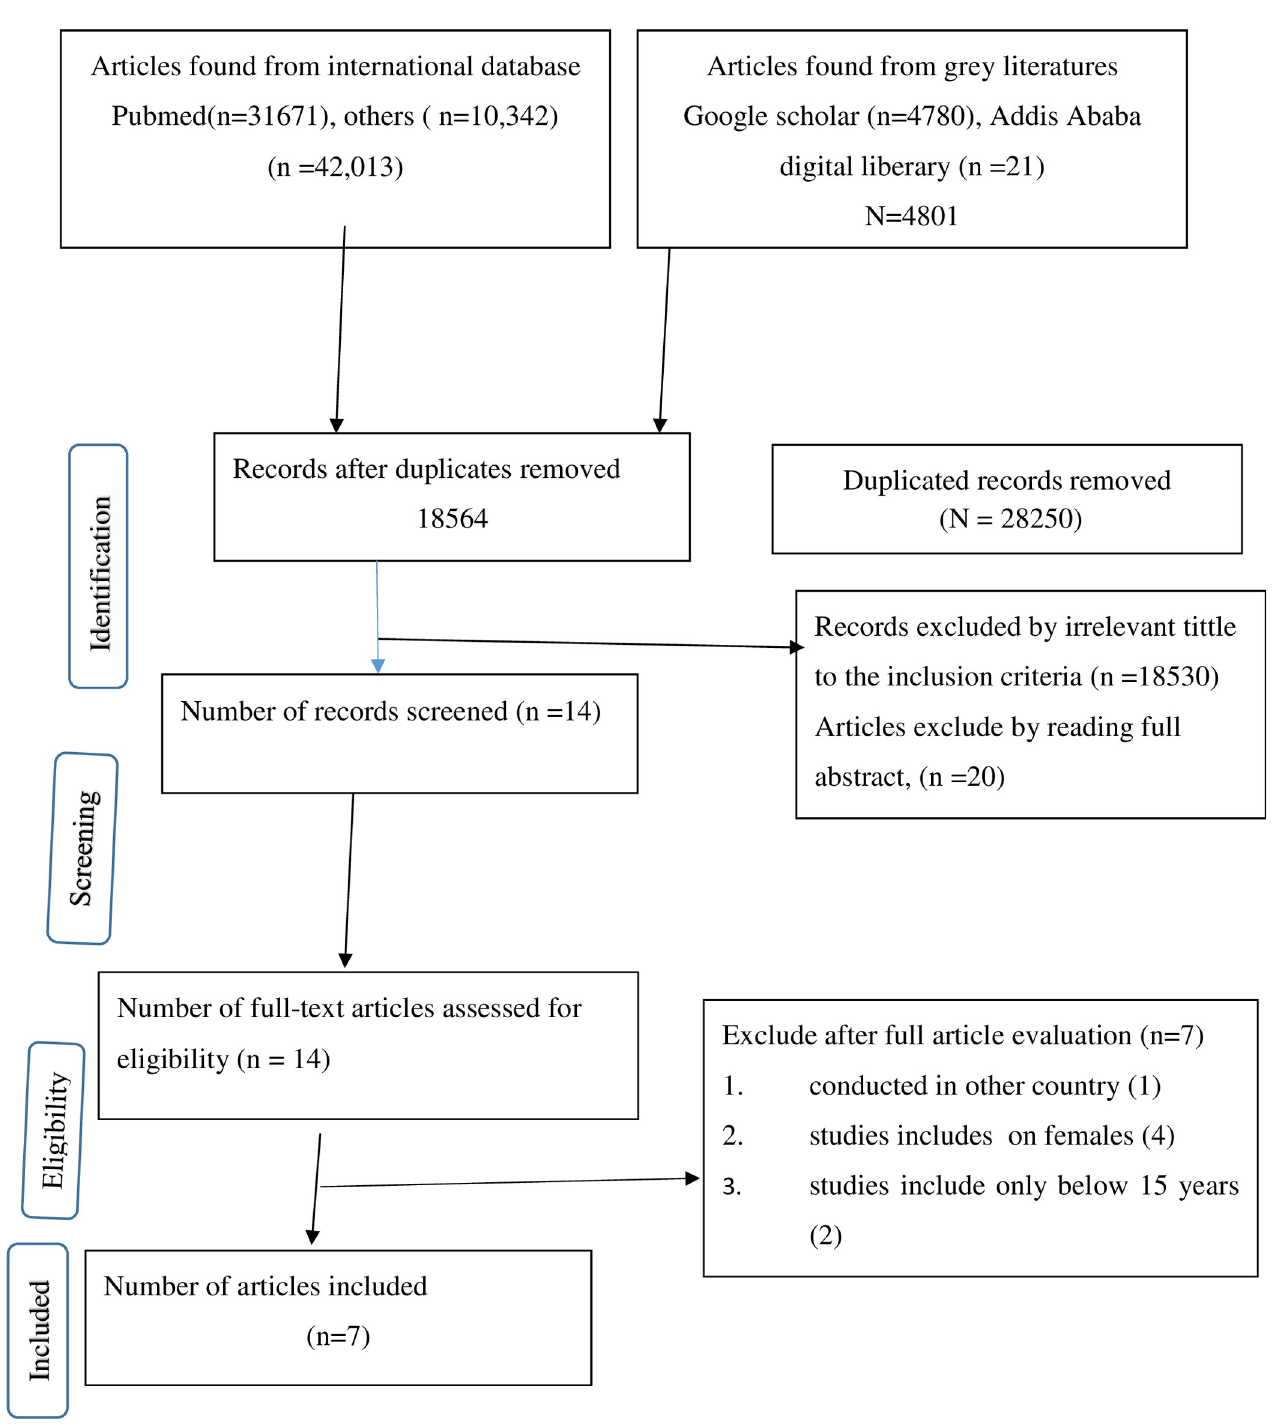
Fig 1. PRISMA flow diagram for selection of the included